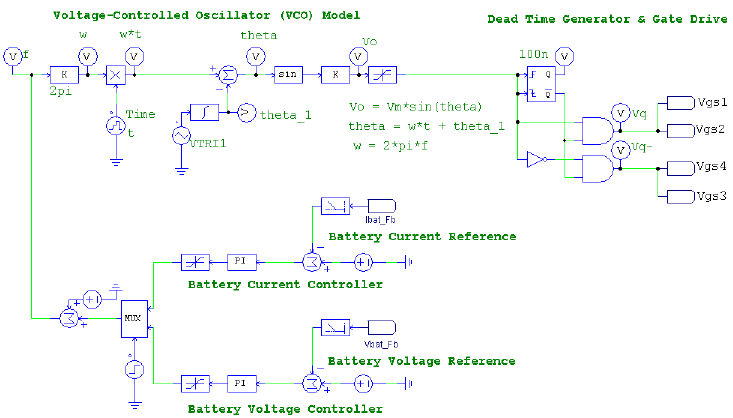
Figure 8. Voltage controlled oscillator sub-model for LLC resonant converter